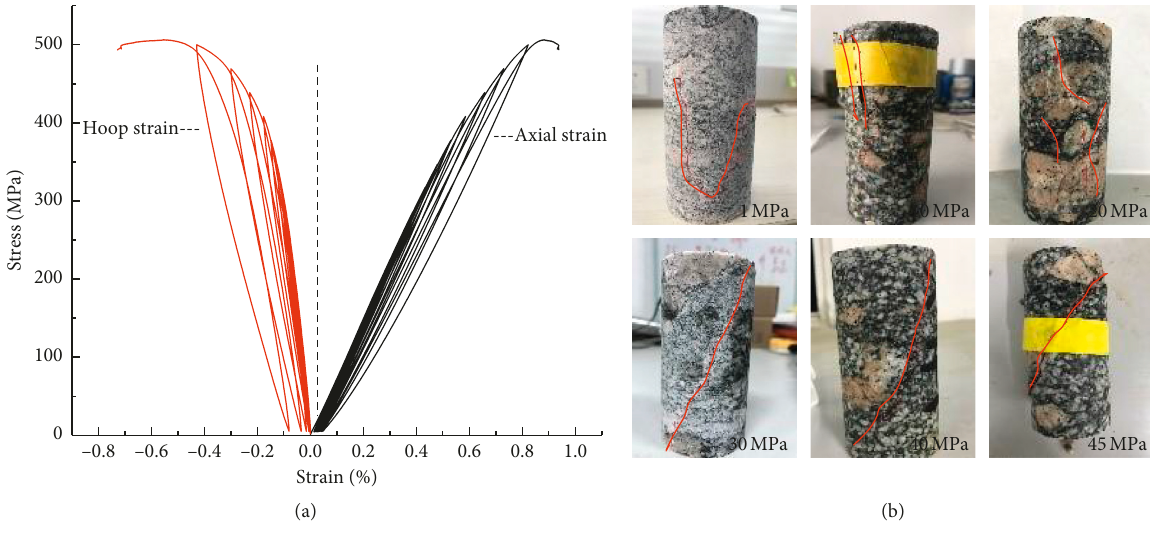
Figure 3: (a) Stress-strain curves and (b) failure modes. Table 2: Mechanical parameters of samples.